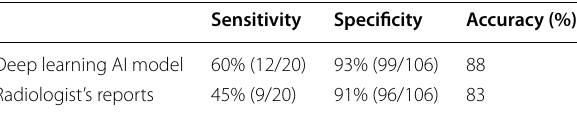
Table 3 Performance on the simulation set of the AI model